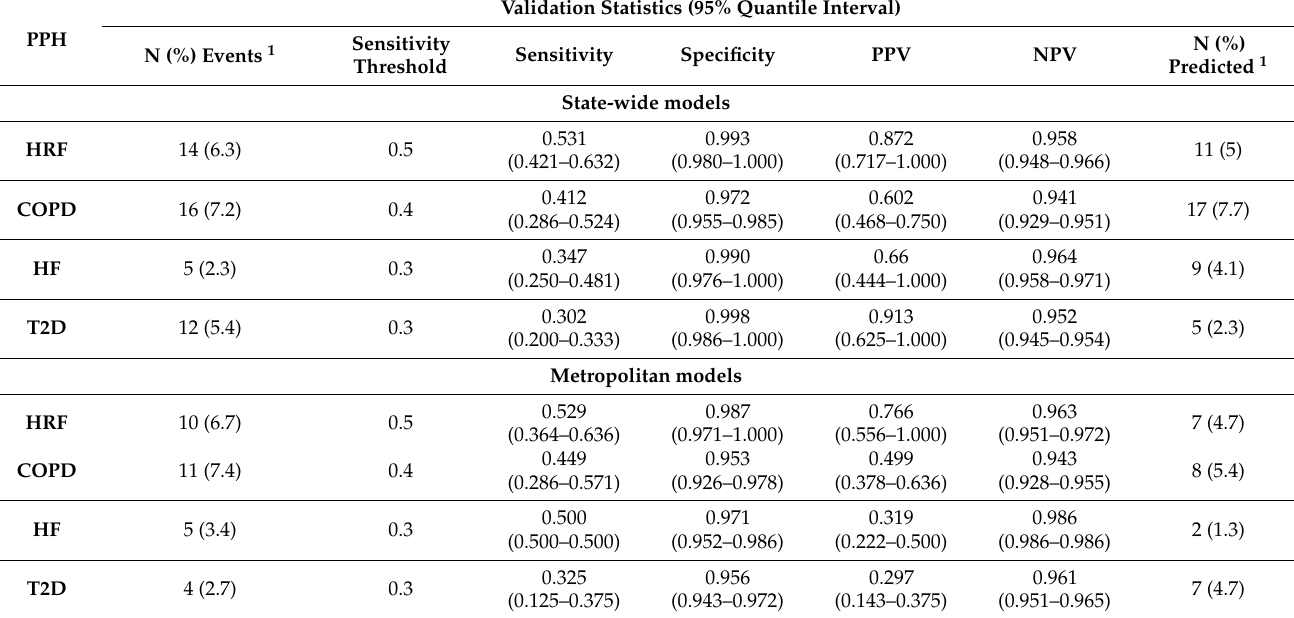
Table 1. Validation statistics for optimal state-wide and metropolitan models for high-risk foot (HRF), chronic obstructive pulmonary disease (COPD), heart failure (HF), and type II diabetes (T2D), with 95% quantile intervals. The number (N) and percentage (%) of outcome cases in each training sample; the sensitivity thresholds selected in the calibration step; and the number and percentage of predicted areas are also shown.